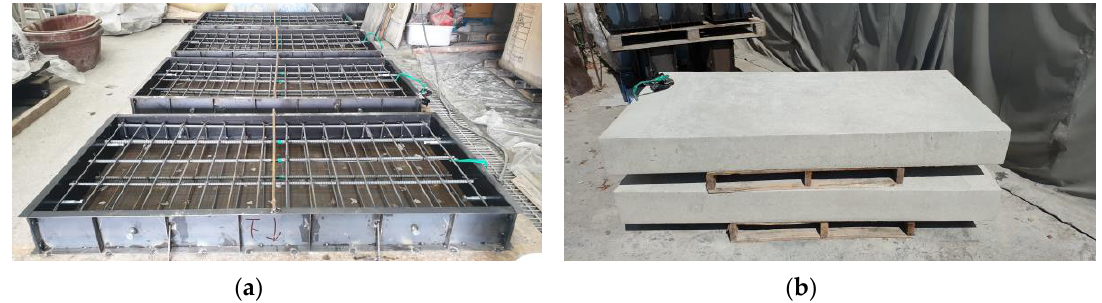
Figure 4. Fabrication of full-size slab specimens: ( a ) steel reinforcement; ( b ) cured specimens.